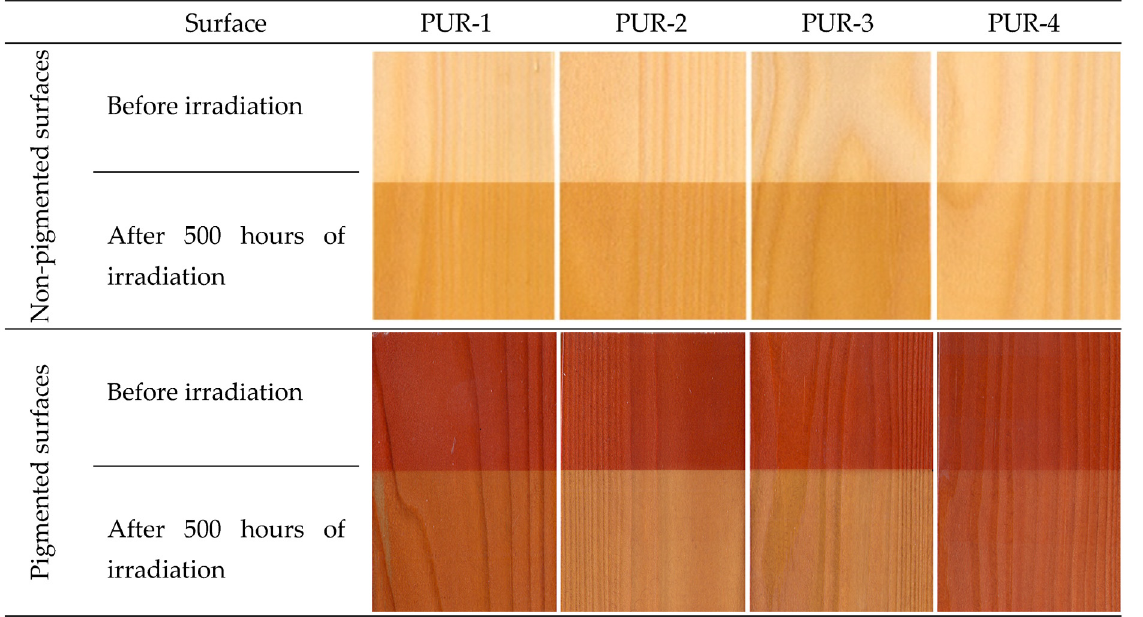
Figure 3. Colour of spruce wood surfaces coated with specific lacquers before and after irradiation in the accelerated aging process.